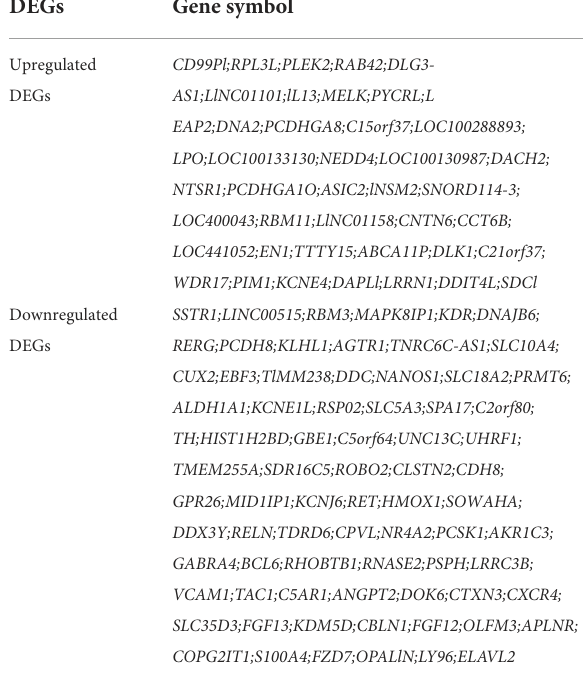
TABLE 1 The DEGs of gene expression profiles (adj. P -value < 0.05, |logFC| > 1.0).